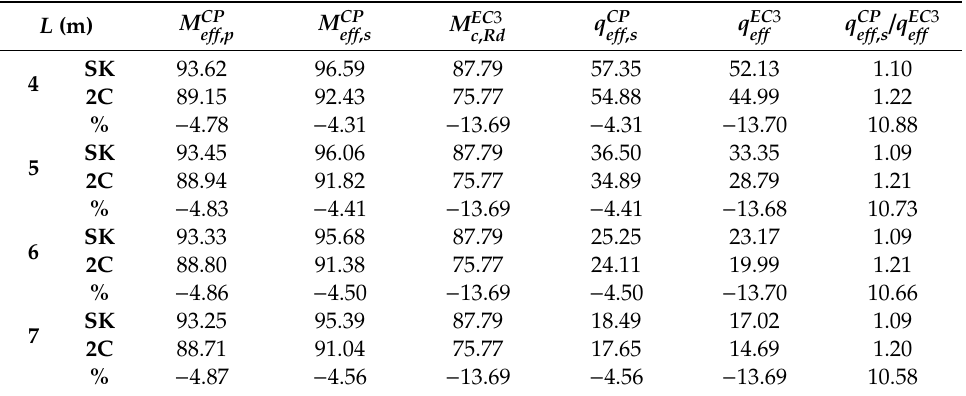
Table 6. Comparison of design ultimate resistances of box sections (Sk) and I-sections (2C) depending on the span